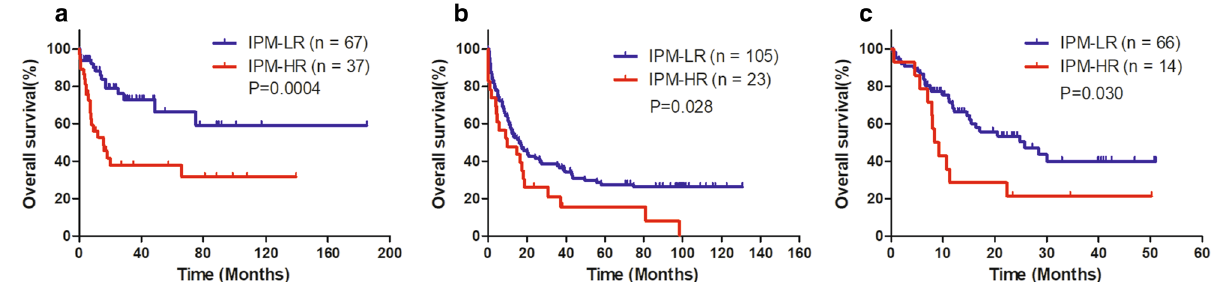
Figure 3. Validation of the prognostic impact of IPM defined risk on OS in three GEO datasets ( a ) OS of AML cases with normal karyotype from GSE71014 ( b ) OS of non-M3 AML cases from GSE37642 ( c ) OS of non-M3 AML cases from